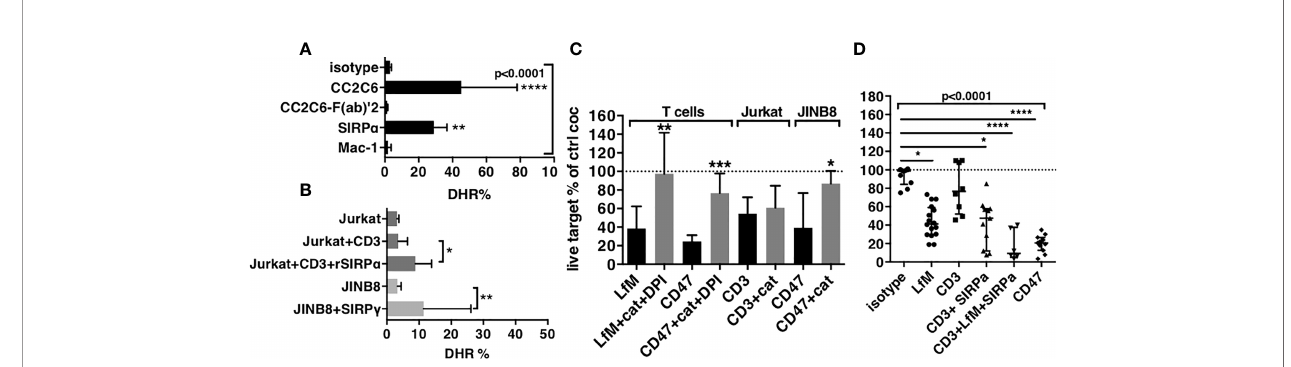
FIGURE 4 | Production of ROS is stimulated in ADCC and contributes to cytotoxicity. (A) Stimulation of ROS in PMNs by mAbs to PMNs. (B) Stimulation of ROS in PMNs by cocultures with targets and mAbs. For (A, B) , median and IQR of percentages of expression of DHR in PMNs after 1-h stimulation. For (A) , n = 6 – 15 different donors. P -values from Kruskall – Wallis test indicated on top, P -values from Dunn ’ s multiple comparison post-test on top of pairs: ** P < 0.01; **** P < 0.0001. For (B) , n = 6 – 10. P -values of Wilcoxon matched pair test: * P < 0.05; ** P <0.01. (C) Inhibition of cytotoxicity by catalase (cat), in the presence of DPI when indicated, n = 6 – 25. Median and IQR, P -values of Wilcoxon matched pair test: * P < 0.05; ** P < 0.01; *** P < 0.001. (D) Reconstitution of the cytotoxicity induced by anti-CD47 mAb CC2C6 (CD47) using anti-CD3 (CD3) + anti-SIRP a (SIRP a ) + LPS + fMLP (LfM), n = 6 – 14. Median and IQR, P -values from Kruskall – Wallis test indicated on top, P -values from Dunn ’ s multiple comparison post-test on top of pairs: * P < 0.05; ** P < 0.01; **** P <